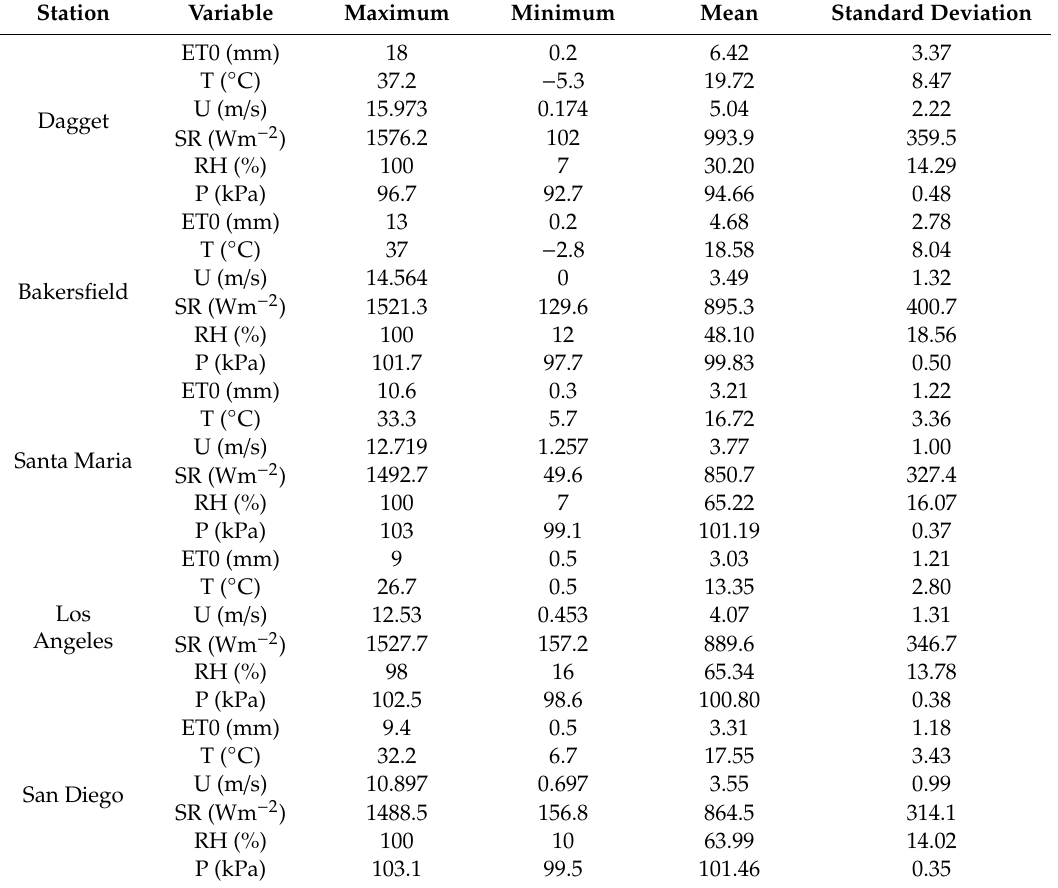
Table 1. Statistical properties of the agro-meteorological datasets of